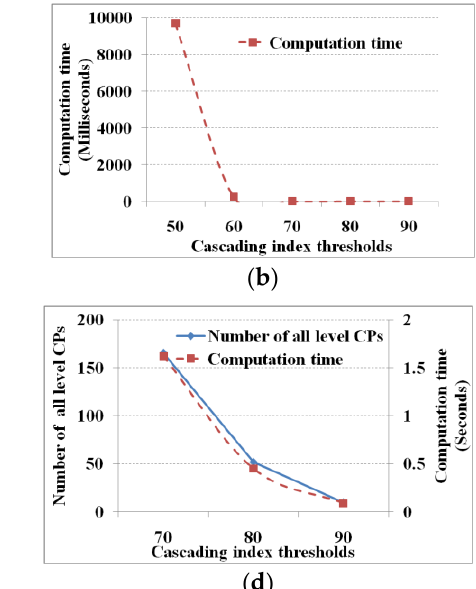
Figure 4. Performance under different support thresholds. ( a ) Number of one-level cascading patterns and computation time; ( b ) Total number of cascading patterns and computation time; ( c ) Computation time of linking and pruning; ( d ) Partial enlargement of ( c ).